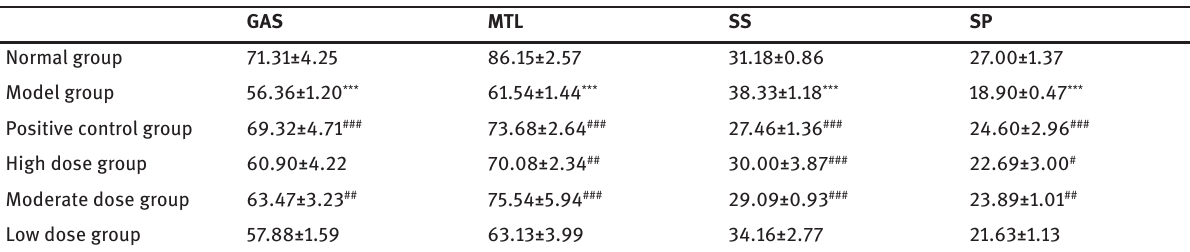
Table 3: Contents of MTL, GAS, and SS of rats.